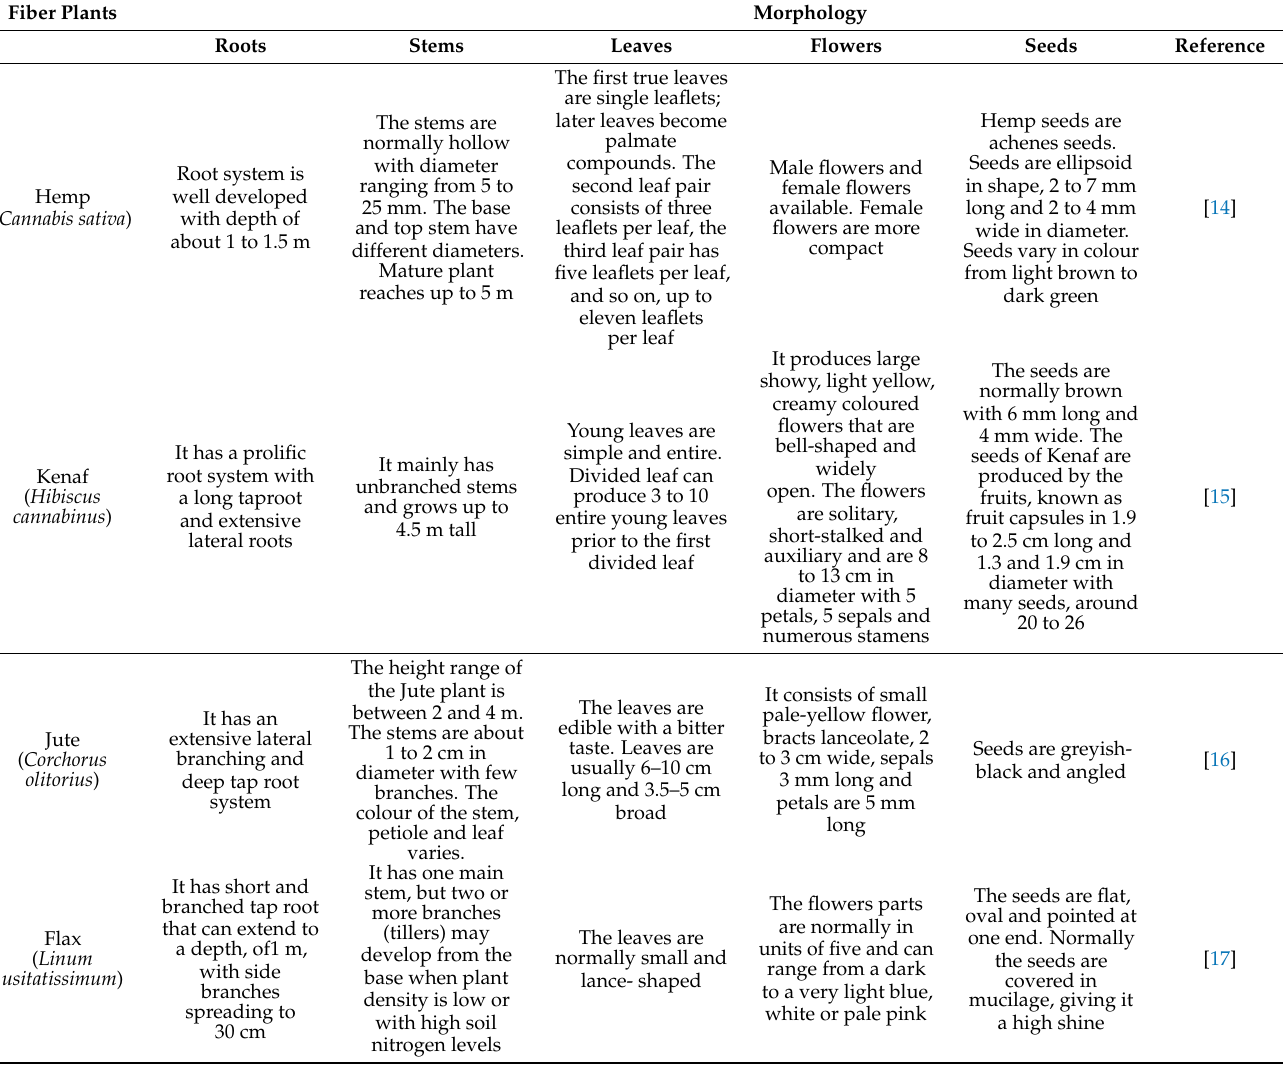
Table 1. Morphology and specifics characteristics of bast fiber plants (Hemp, Kenaf, Jute and